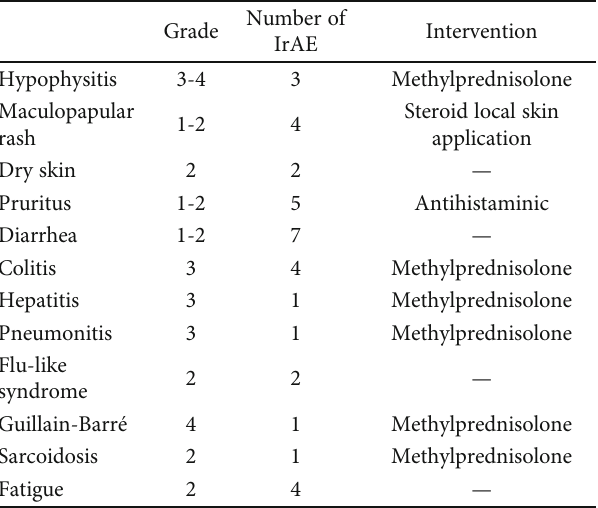
Figure 2: Case illustration. Sagittal section of a gadolinium-enhanced magnetic resonance image from a patient who developed acute symptomatic immune-related hypophysitis leading to an isolated insu ffi ciency of the corticotropic axis. The patient had an Addison crisis three weeks after the fourth administration of IPI (cumulative dose 1080mg). The MRI image reveals a di ff usely swollen and gadolinium- enhanced pituitary gland with a hypointense lesion in the right adenohypophysis and thickening of the stalk. Laboratory fi ndings showed undetectable ACTH levels at the time of diagnosis. The patient was diagnosed with posttraumatic stress disorder (PTSD) related to the symptoms of an Addison crisis with comorbid depressive mood, fatigue, suicidal ideation, psychomotor retardation, and severe subjective neurocognitive symptoms. After one year of psychiatric follow-up, the patient recovered from depression and PTSD; however, he had a recurrence of depression two years later due to fear of recurrence, which again was successfully treated after psychiatric intervention. Table 2: Overview of immune-related adverse events